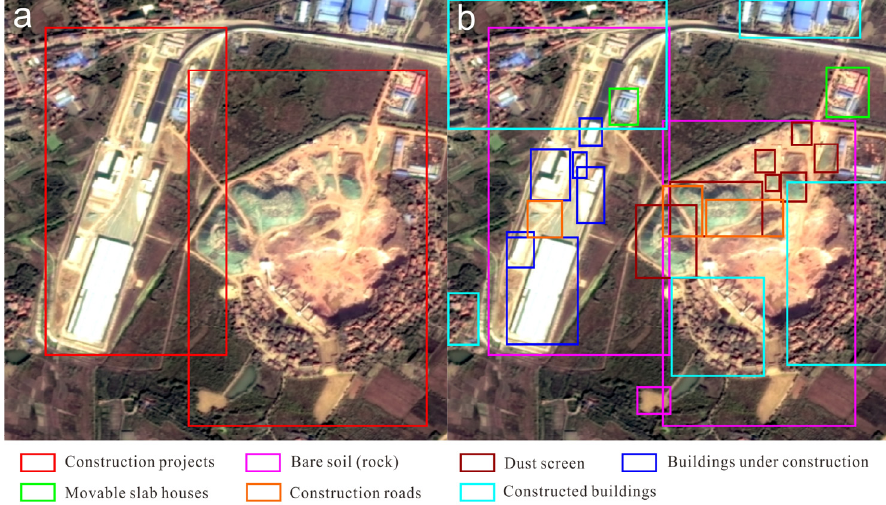
Figure 4. Construction projects in ( a ) and detailed ground objects in ( b ) labeling examples.